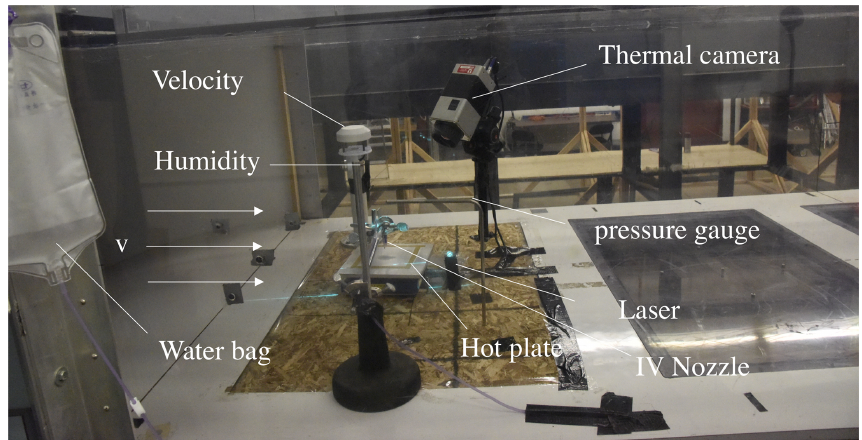
Figure 4. Photograph of the laboratory experimental setup inside the wind tunnel used to validate the mass measurement of water droplets for various environmental